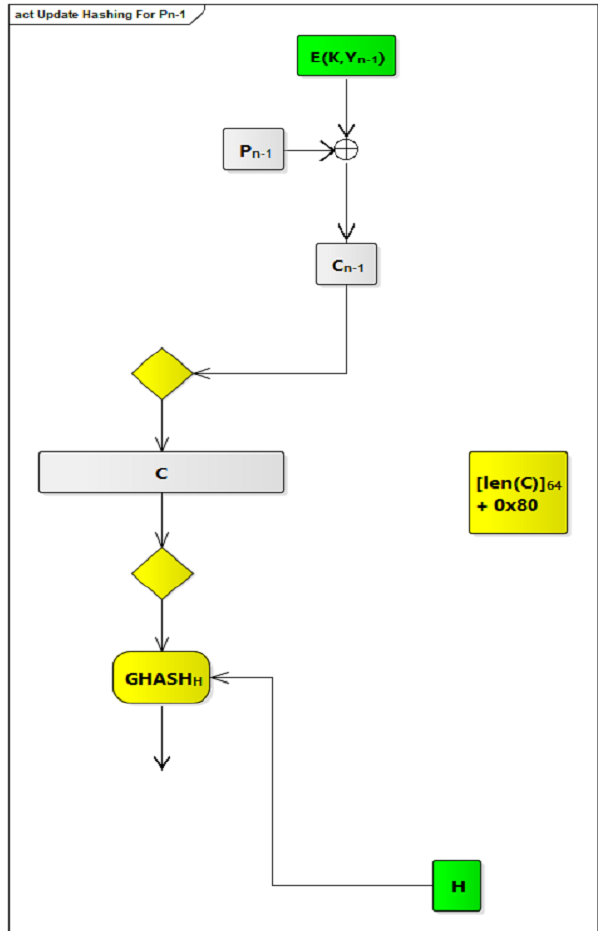
Figure 13. Update hashing for P n − 1